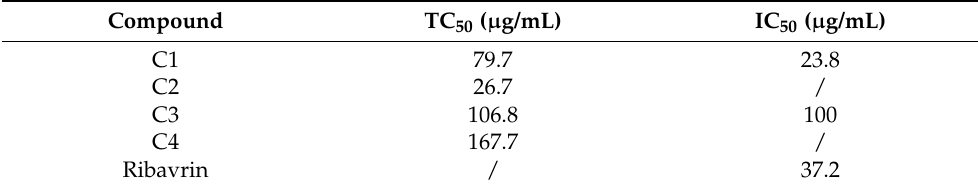
Figure 2. The antiviral activity of C1 isolated from EA extract against the cytopathic effect of the H1N1 virus. A monolayer of MDCK cells was infected with the H1N1 virus (50 × TCID50) by the time the cells fulfilled 90% of the bottom. After 2 h of incubation, the supernatant was carefully removed, and a sample diluted by 1640 medium was added to each well. Virus-induced CPEs are recorded each day until all the cytopathic cultures are in virus control. Inhibition assay of cytopathic effects (CPE) was evaluated to ascertain the antiviral activity of C1 and tissue culture infective dose (TC 50 ), and the 50% effective concentration (IC 50 ) was used to measure by regression analysis. ( A ) MDCK control; ( B ) H1N1 control; ( C ) H1N1 + C1; ( D ) H1N1 + ribavirin; Magnification: 200×. Table 1. Anti-IVA of